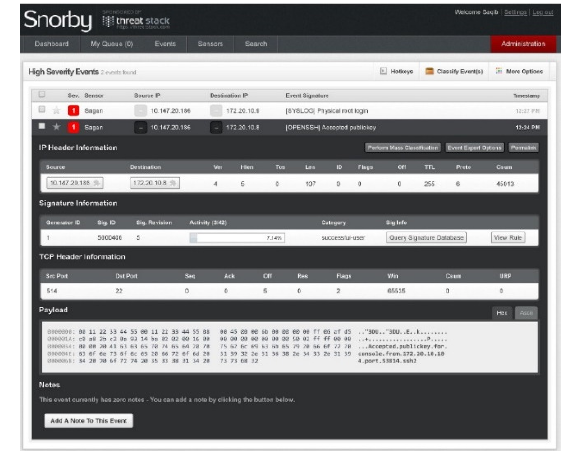
Fig. 27: Attack event analysis packet